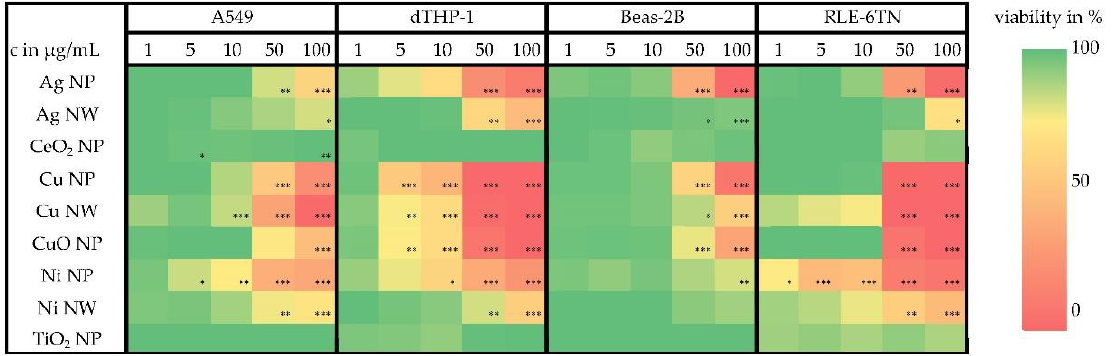
Figure 3. Impact of nanomaterials on the ATP content of A549, Beas-2B, RLE-6TN, and dTHP-1 cells after incubation with five different doses of the nanomaterials. The ATP content of incubated samples was normalized to an untreated control. Significantly different from negative controls: * p ≤ 0.05, ** p ≤ 0.01, *** p ≤ 0.001 (ANOVA - Dunnet’s t- test).